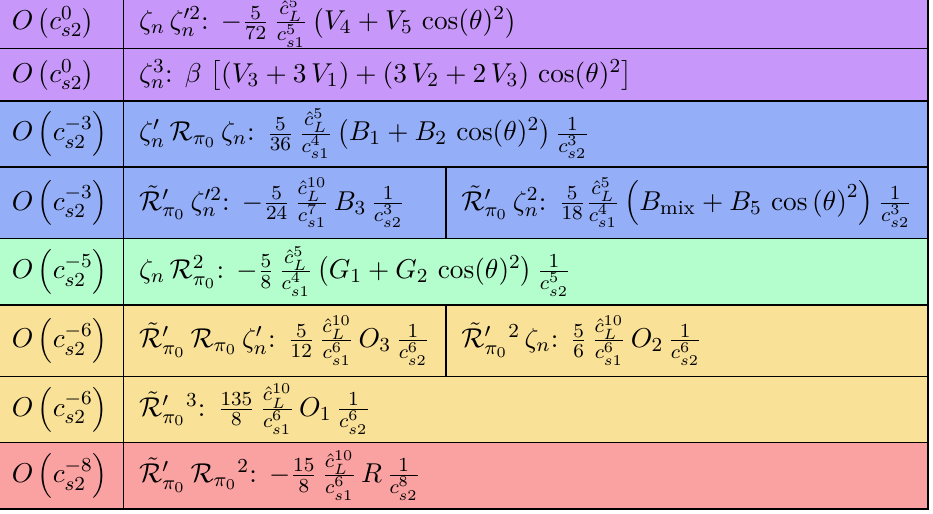
Table 2 . Bispectrum of ζ n : f NL for a squeezed configuration and c s 2 (cid:28) 1